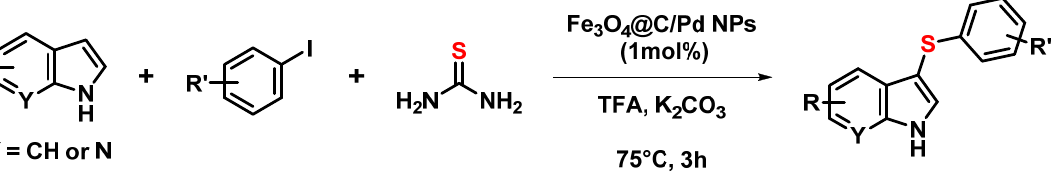
Figure 13. Pd NP trapped in a hydrophobic pocket of HPMC, catalytic center of C-N coupling [94]. five times